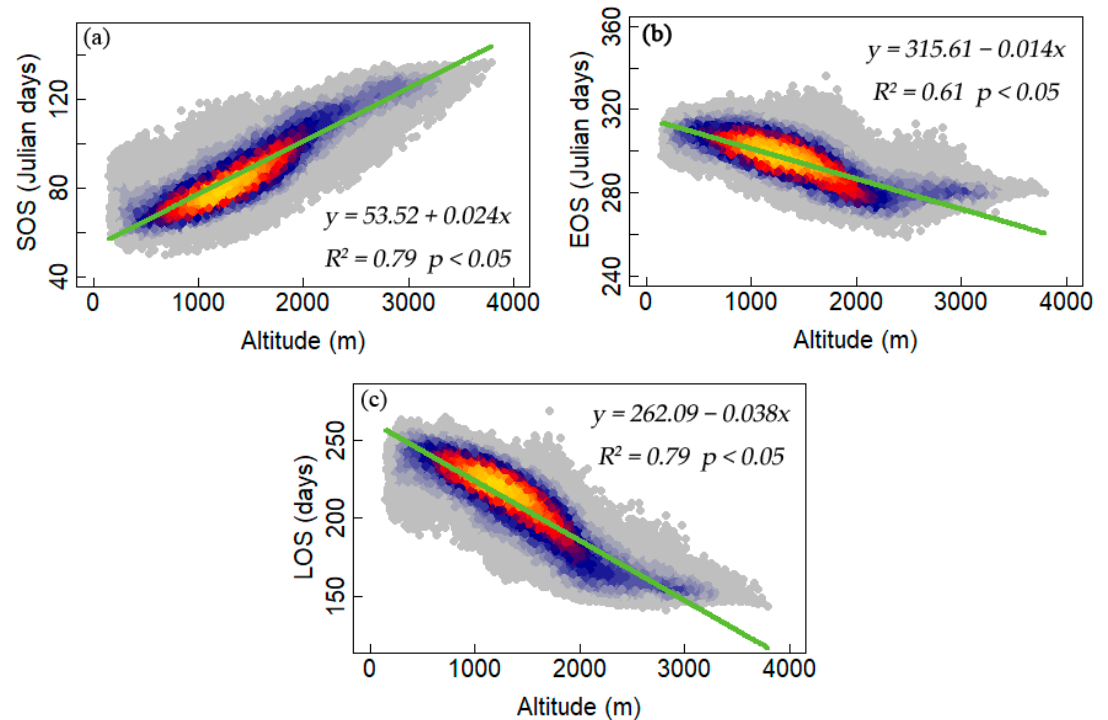
Figure 3. Relationship between elevation and mean SOS ( a ), EOS ( b ), and LOS ( c ) for forests in the QMs from 2001 to 2017. SOS, EOS, and LOS are the abbreviations for the start of the growing season, the end of the growing season, and the length of the growing season, respectively. Warm color represents high point density.